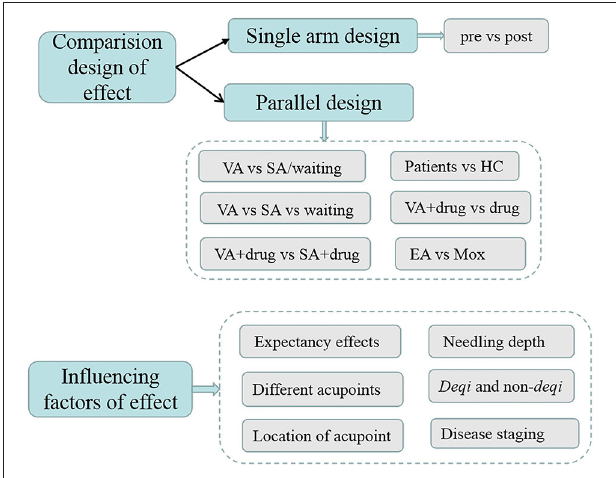
FIGURE 5 | Topics of studies on acupuncture for diseases based on